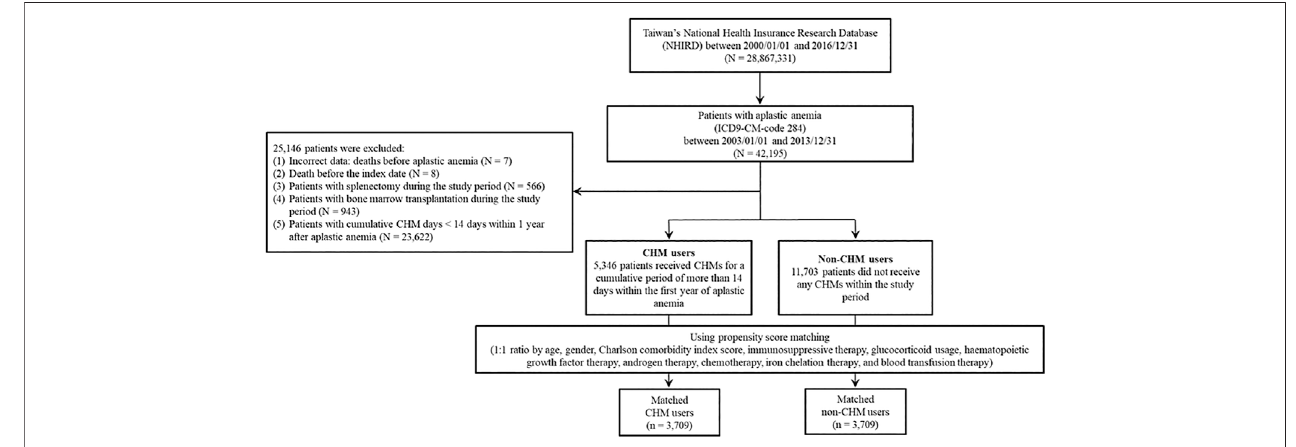
FIGURE 1 | Flowchart of aplastic anemia patient